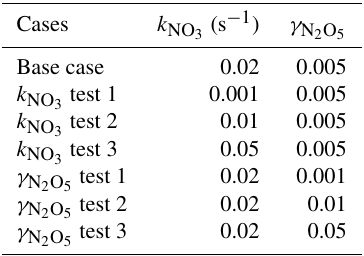
Table 1. List of the parameter sets in the base case and sensitivity tests.